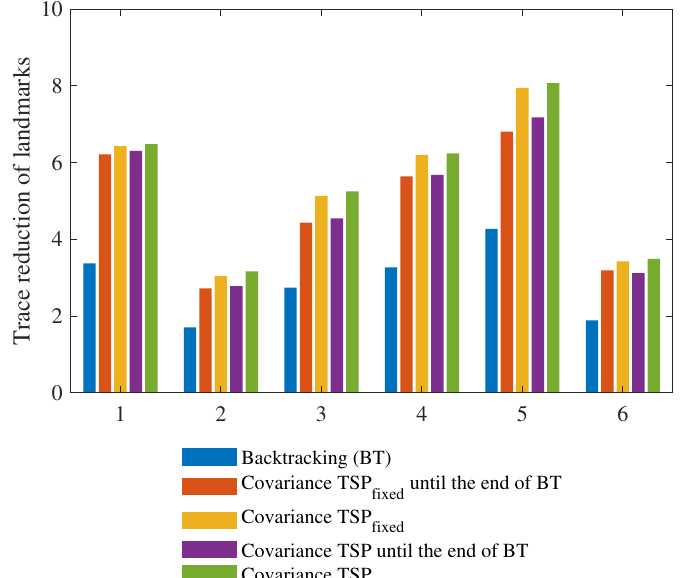
Figure 13. The reduction of the trace sum of the landmarks by backtracking and the average reduction of the trace sum of the landmarks by Covariance TSP fixed and Covariance